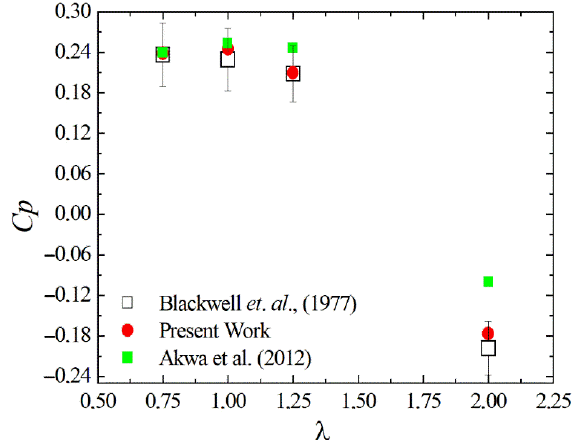
Figure 5. Comparison between the power coefficient ( C P ) as a function of λ obtained in the present work and that from the literature